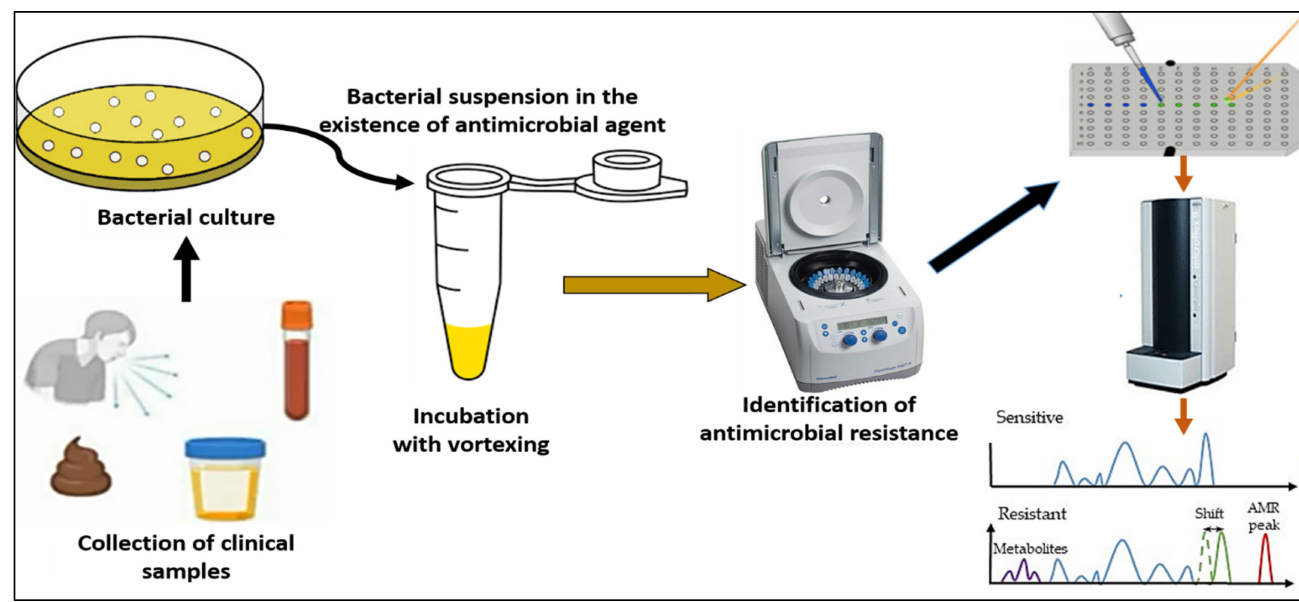
Figure 2. A workflow for MALDI-TOF detection of antimicrobial